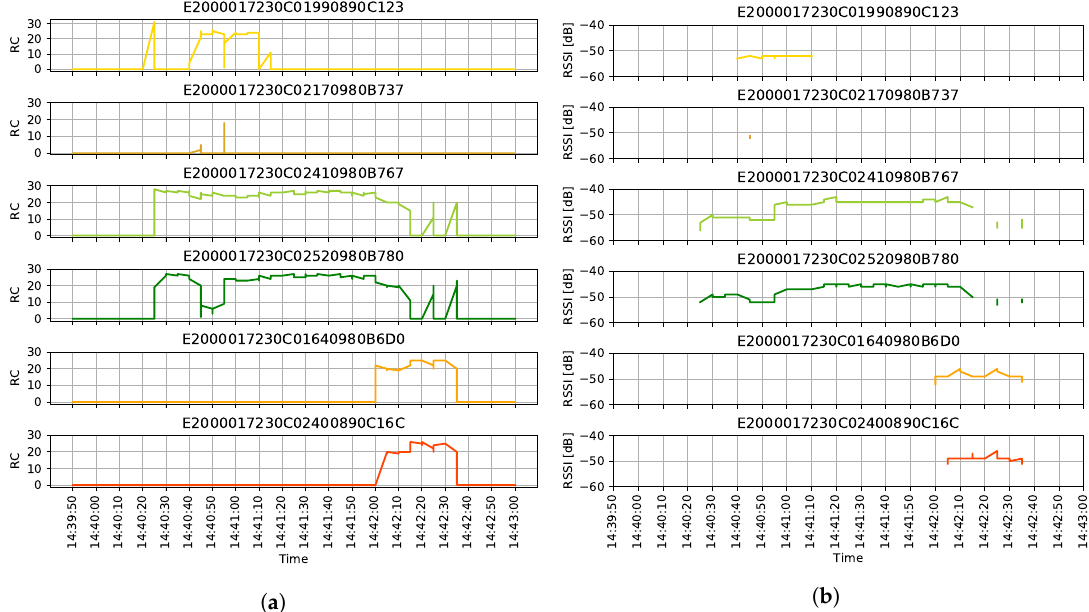
Figure 14. RFID measurements. ( a ) The Read Count of the tracked RFID tags. ( b ) The RSSI value of the detected RFID